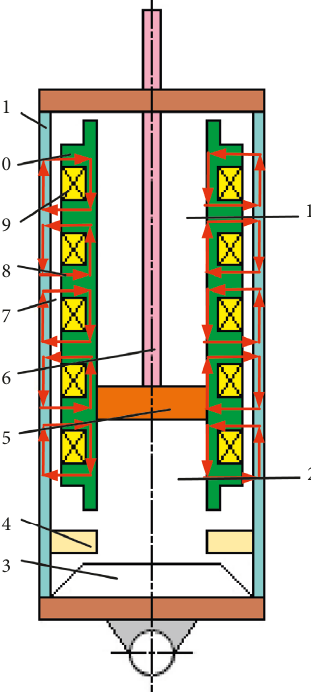
Figure 16: (a) Schematic configuration of multiple-coil MR damper. (b) An enlarged section view including magnetic flux and active area. 1, main cylinder; 2, reservoir tube; 3, check valve in the piston valve; 4, piston valve; 5, foot valve; 6, check valve in the foot valve; 7, outer tube; 8, inner tube; 9, accumulator; 10, seal com- ponents; 11, coil; 12, magnetic guide ring I 13, retaining ring; 14, opening; 15, magnetic guide ring; 16, active area I; 17, magnetic flux; 18, nonmagnetic ring; 19, active area II; 20, active area III; 21, flow channel [45].